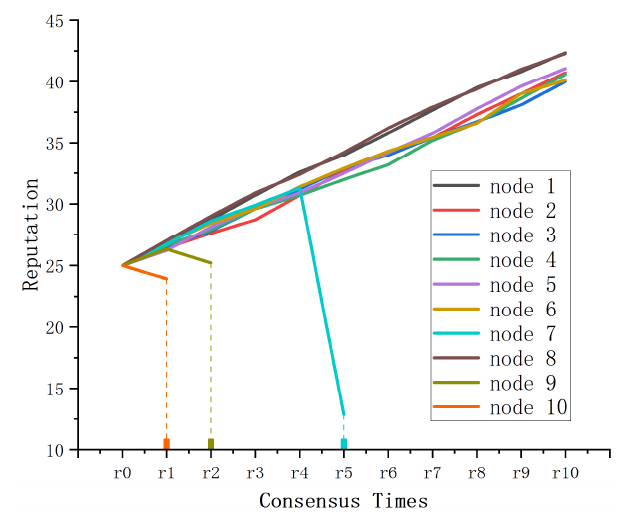
Figure 6. Changes of reputation of 10 nodes.